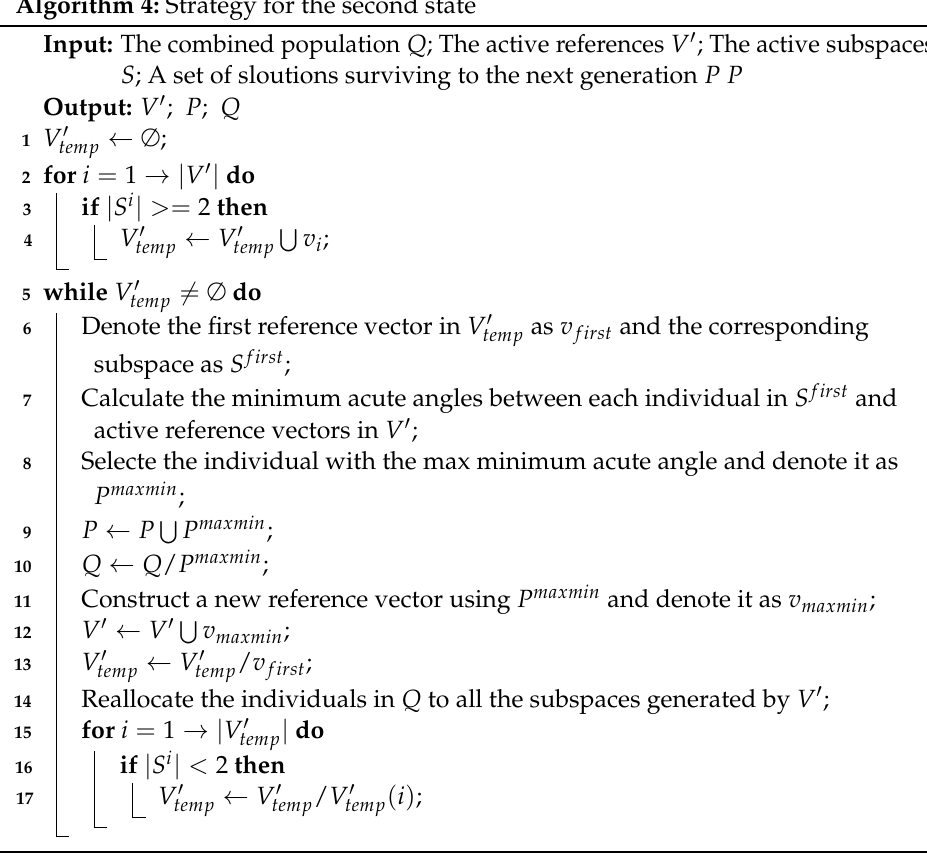
Figure 4. Example showing the strategy for the first state where the red asterisks indicate the candi- date solutions. ( a ) Predefined reference vectors. ( b ) Delete inactive reference vectors. ( c ) Construct new reference vector using the solution pointed by the yellow arrow. Algorithm 4: Strategy for the second